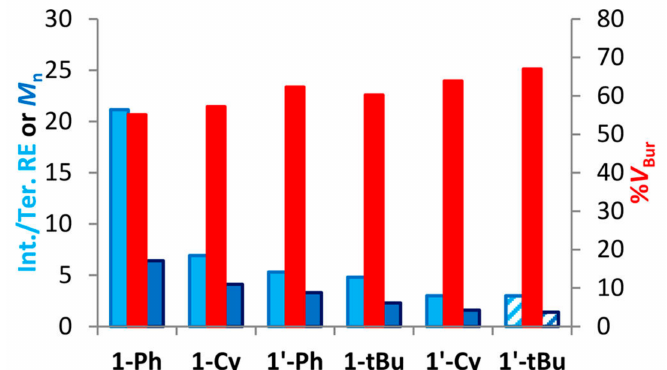
Figure 4. Graphical comparisons of trends in Int./Ter. RE (light blue) and M n (dark blue; in kDa) with percentage of buried volume % V Bur (red). Experimental data for 1 (cid:48) - t Bu are reported separately since they were obtained at slightly lower temperature (100 ◦ C, see Reference [37] for details). Catalysts are ordered by decreasing M n . Reprinted with permission from Reference [37]. Copyright 2018 American Chemical